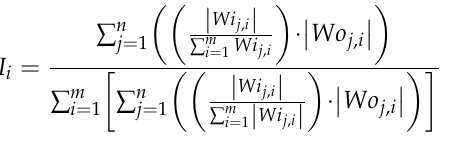
gives the obtained parameters for weights and biases that best fit the ANN model. Table 4. Adjusted weights and biases for proposed ANN.